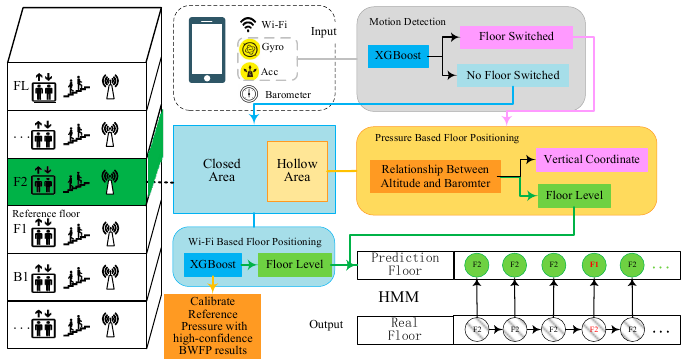
Figure 1. System overview design.